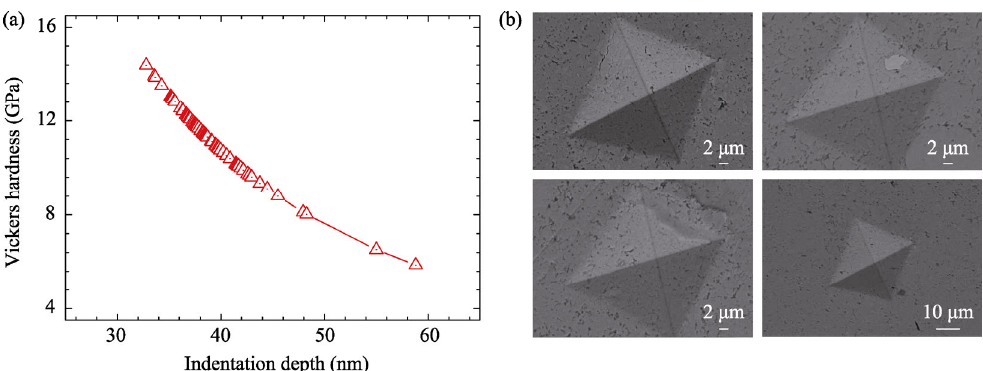
Fig. 4 (a) Vickers hardness of Mo 2 Ga 2 C vs. indentation depth where the hardness at the depth of 0.02 nm/s and (b) Vickers indentation conducted on Mo 2 Ga 2 C with the load at 1000 mN.